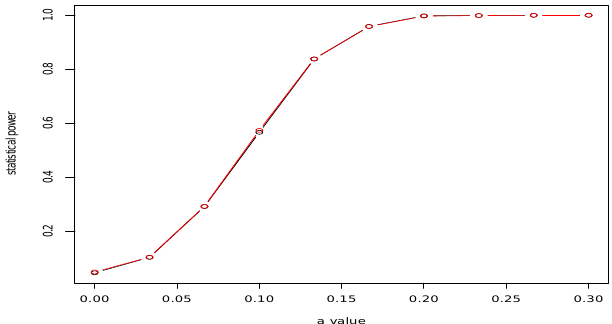
Figure 6. The comparison of the statistical power of scenario (S1) and